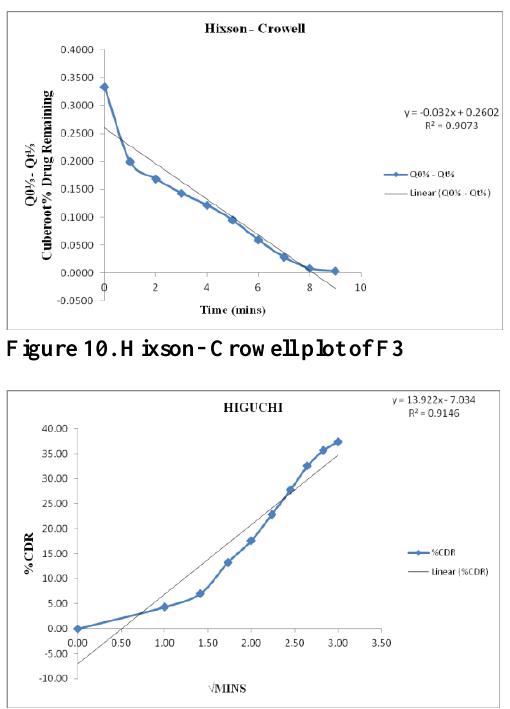
Figure 11. Higuchi plot of